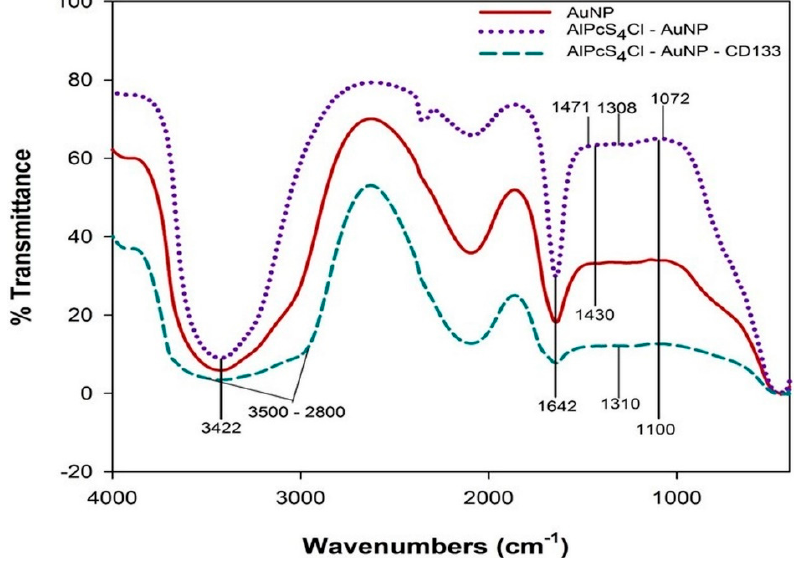
Figure 6. FTIR spectrum of AuNPs, AlPcS 4 Cl–AuNP conjugate and AlPcS 4 Cl–AuNP–CD133 conjugate.